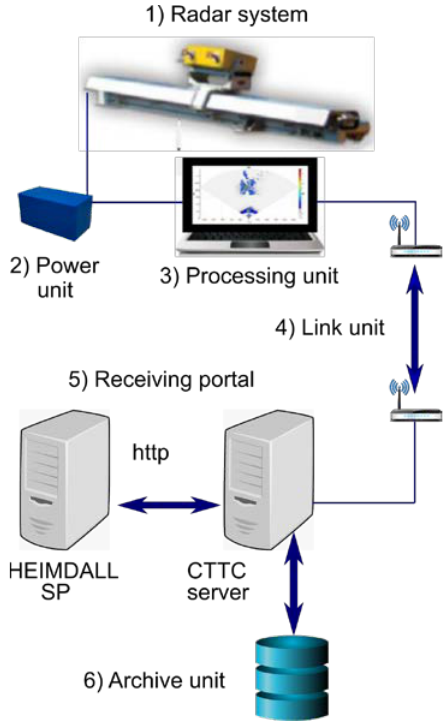
Figure 8: scheme of the connection and data link between the local radar station and the HEIMDALL